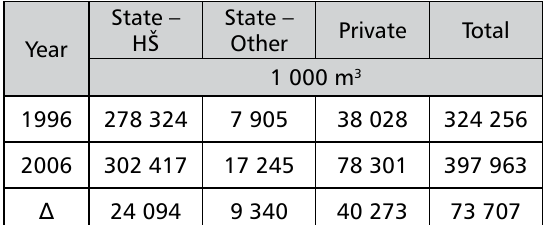
Summary of growing stock distribution (source [8])